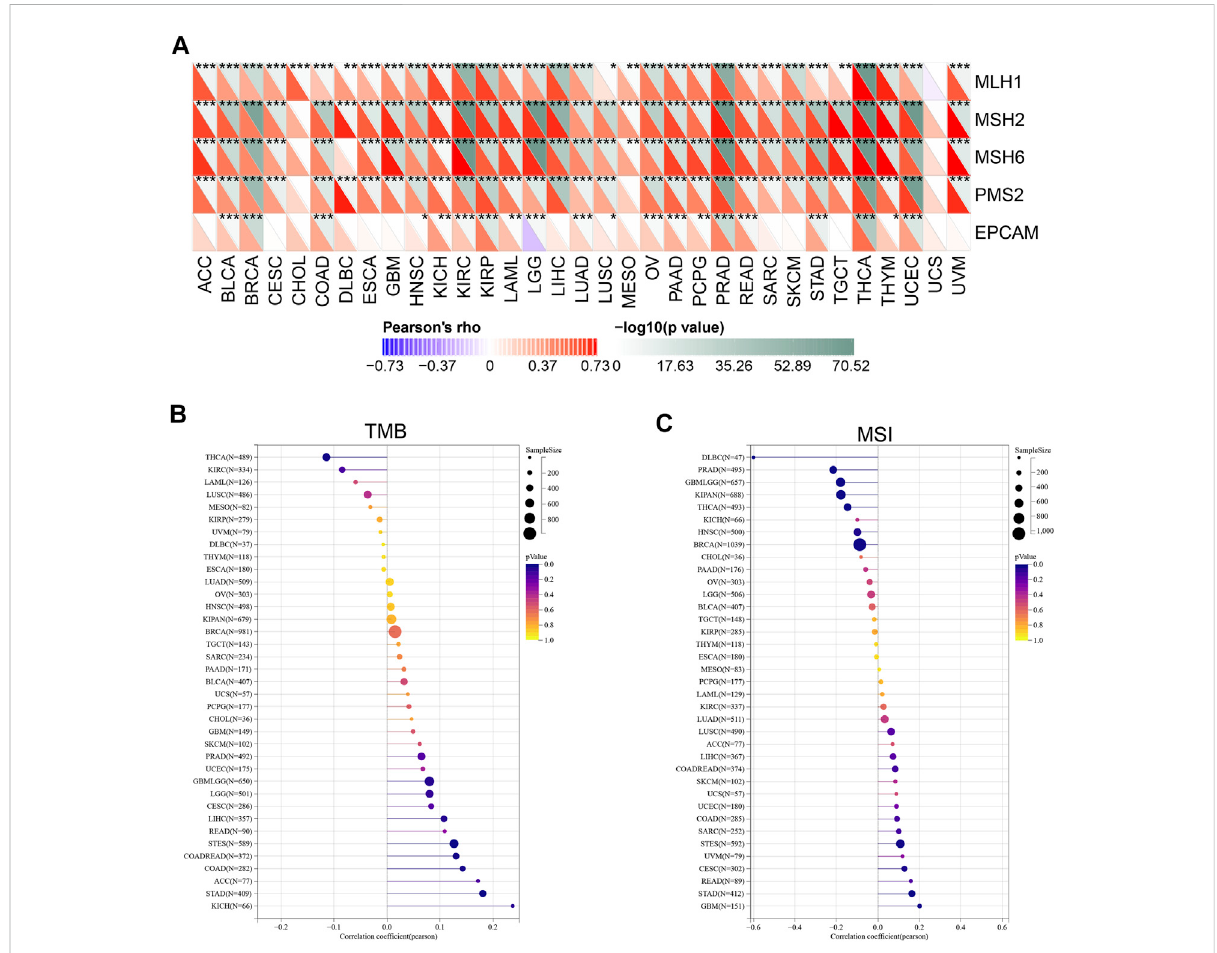
FIGURE 8 The correlation between YTHDF2 expression and the MMR (A) , TMB (B) , and MSI (C) . * p < 0.05; ** p < 0.01; *** p <